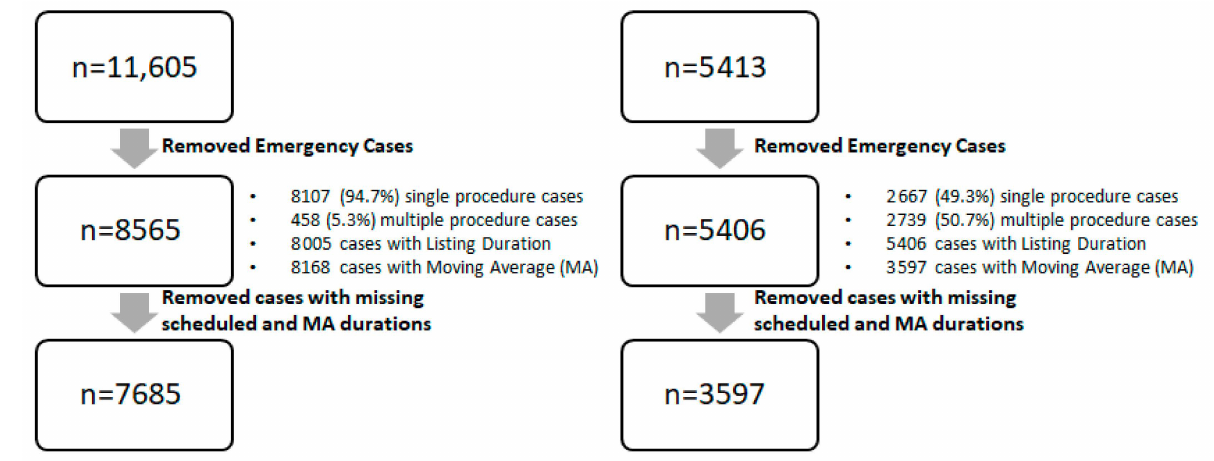
Figure 1. Data-cleaning process (MA: Moving